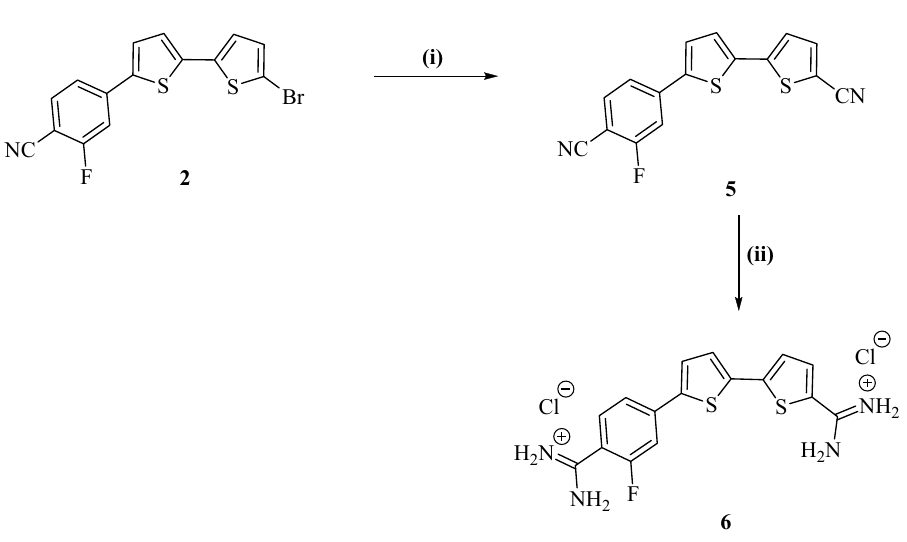
Figure 1. Synthesis scheme for the new α-terthienylbenzamidine derivative 4 .